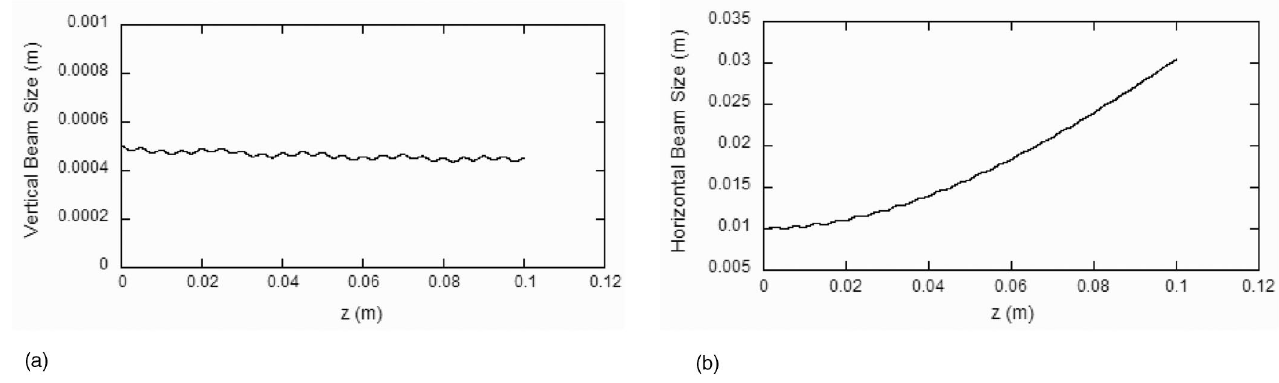
FIG. 1. (a) Vertical beam size, for the nominal natural focusing case (normalized emittance of 1.4 mm, 20 A, 0.266 T wiggler focusing field). (b) Horizontal beam